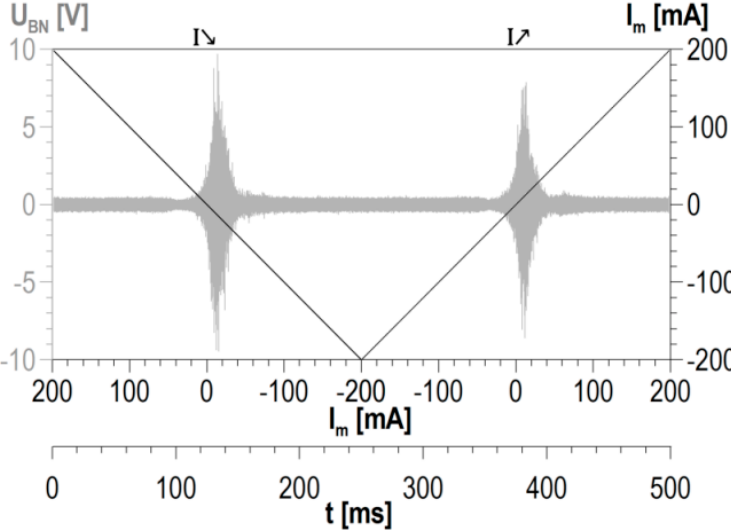
Figure 3. Detailed description of a single cycle of changes in magnetization.